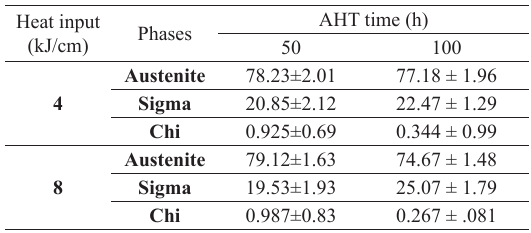
Table 6. Quantification of the austenite, sigma and chi phases in the fusion